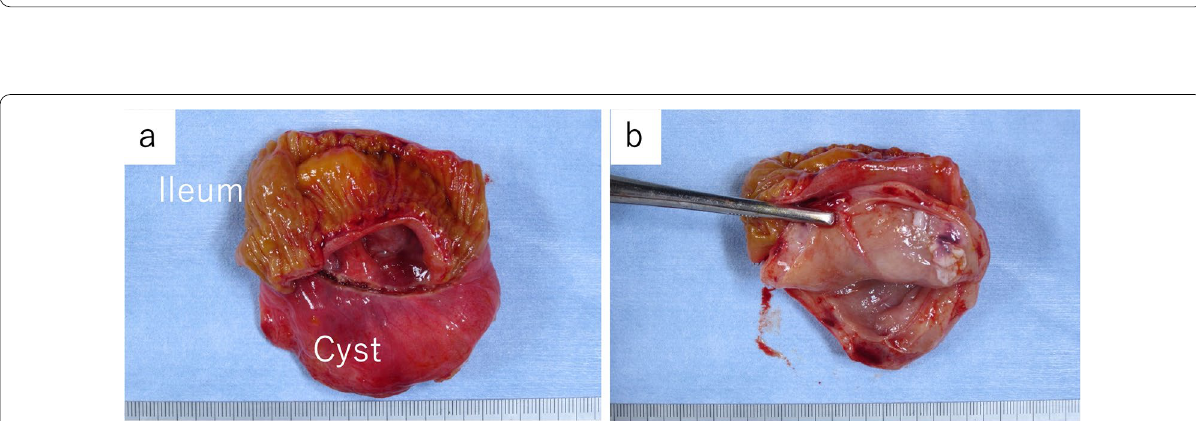
Fig. 4 Extracted specimen. The image shows the specimen at the ileal lumen ( a ). No change in the lumen and no apparent communication were observed with the cyst. The image shows the lumen of the cyst ( b